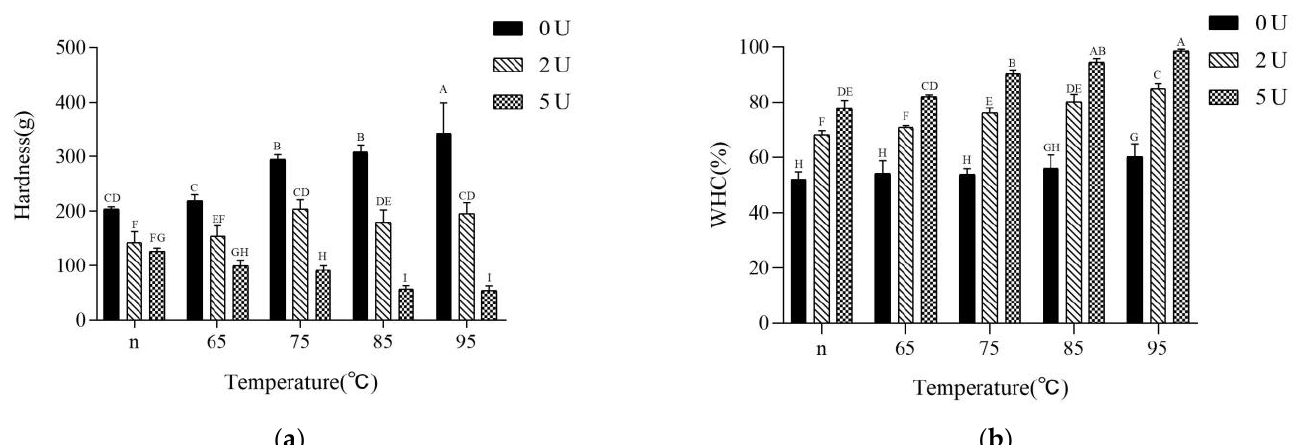
Figure 5. Properties of gels influenced by the different heating levels and PG-treated. ( a ): gel hardness; ( b ): water-holding capacity (WHC). Different capital letters indicate significant differences ( p < 0.05).